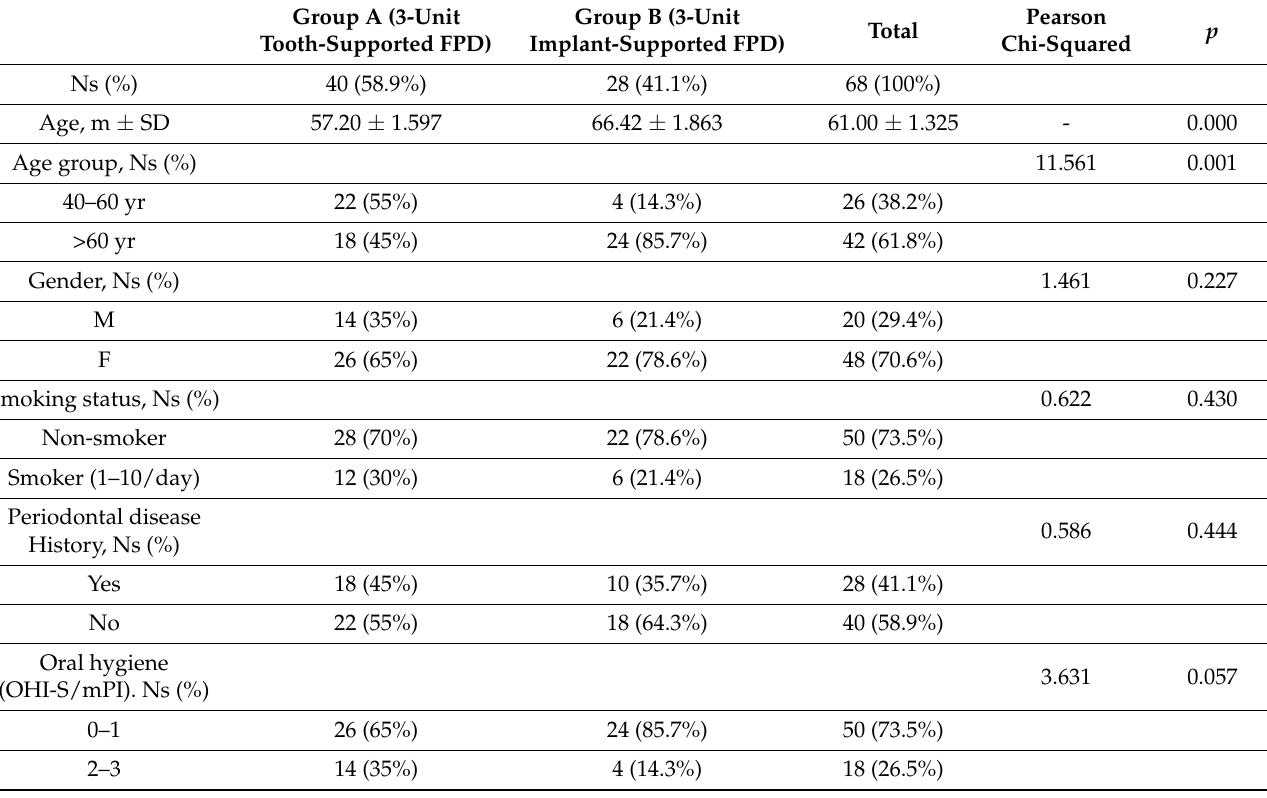
Table 2. Features of the study groups by patients (tooth-supported FPD vs. implant-supported FPD). Group A